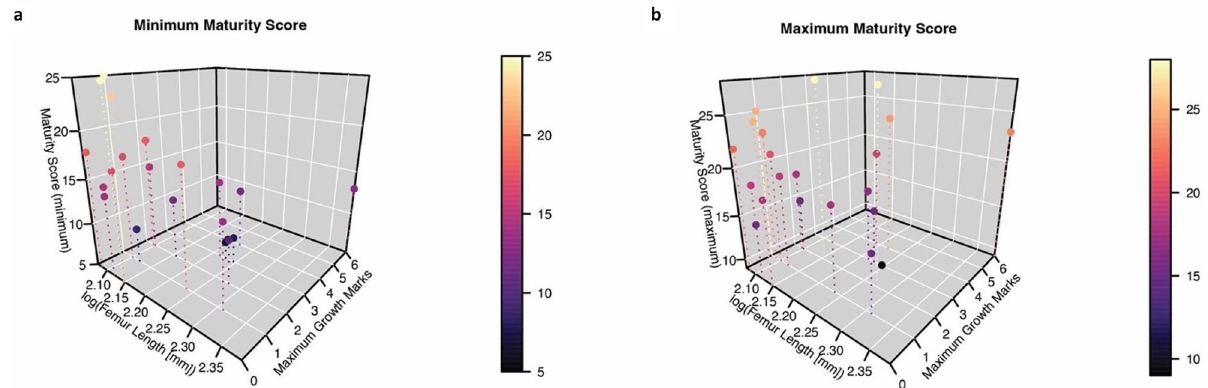
Figure 5. Ontogenetic variables (size, age, and external morphological maturity) in Coelophysis bauri are not strongly correlated with each other. ( a ) log (femur length) versus maximum growth mark count versus minimum maturity score. ( b ) log (femur length) versus maximum growth mark count versus maximum maturity score. Maturity scores were derived from muscle scar and bony fusion data by Griffin 20 . Maturity scores symbolized by color scale. All variables increase from the bottom left corner of each graph to the upper right corner. Note that the data points collectively fail to follow this trajectory, implying that increases in the three metrics of maturity are not strongly correlated through